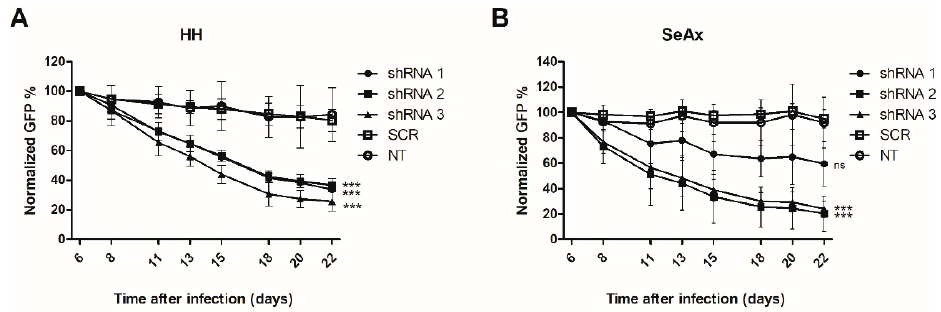
Figure 3. Green fluorescent protein (GFP) growth competition assay with shRNAs targeting TMEM244 in ( A ) SeAx and ( B ) HH. The effect of TMEM244 knockdown on cell growth was assessed by following the percentage of GFP+ cells for 22 days post-transduction, with the GFP percentage normalized to day six ( n = 3); *** p < 0.001, ns—non-significant, based on mixed model analysis; NT—non-targeting,